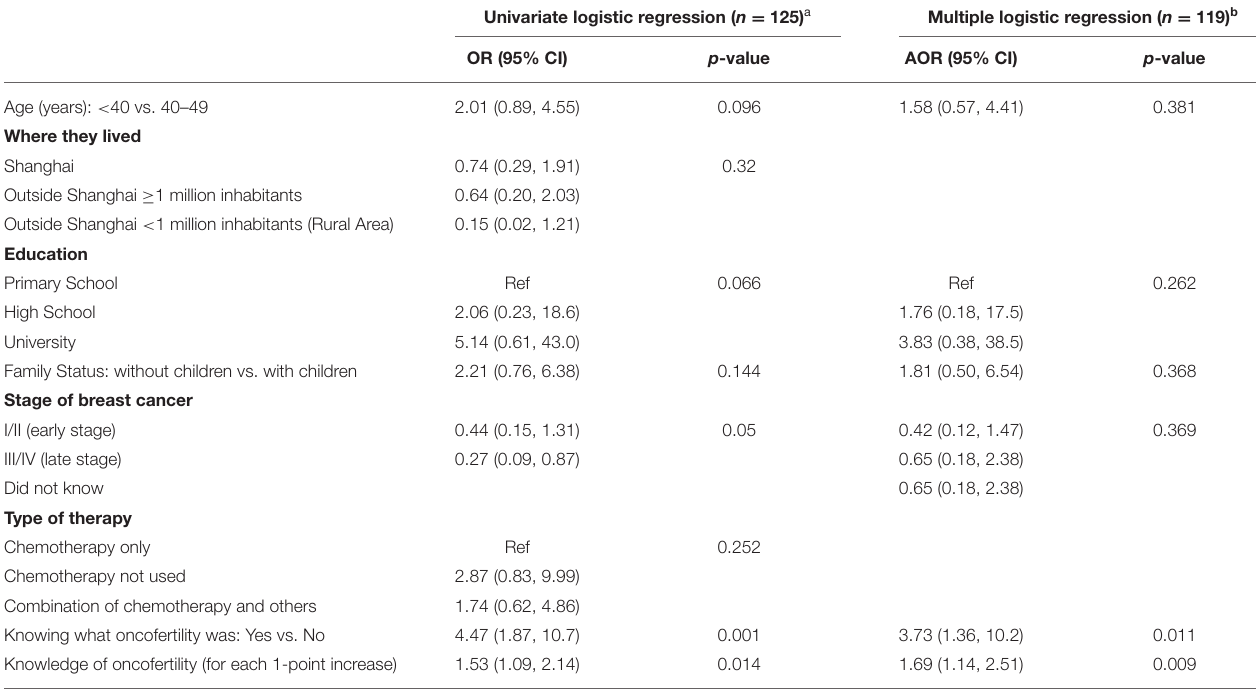
TABLE 8 | Factors associated with receiving oncofertility discussion from their oncologist among breast cancer patients ( n = 125). Univariate logistic regression ( n = 125)